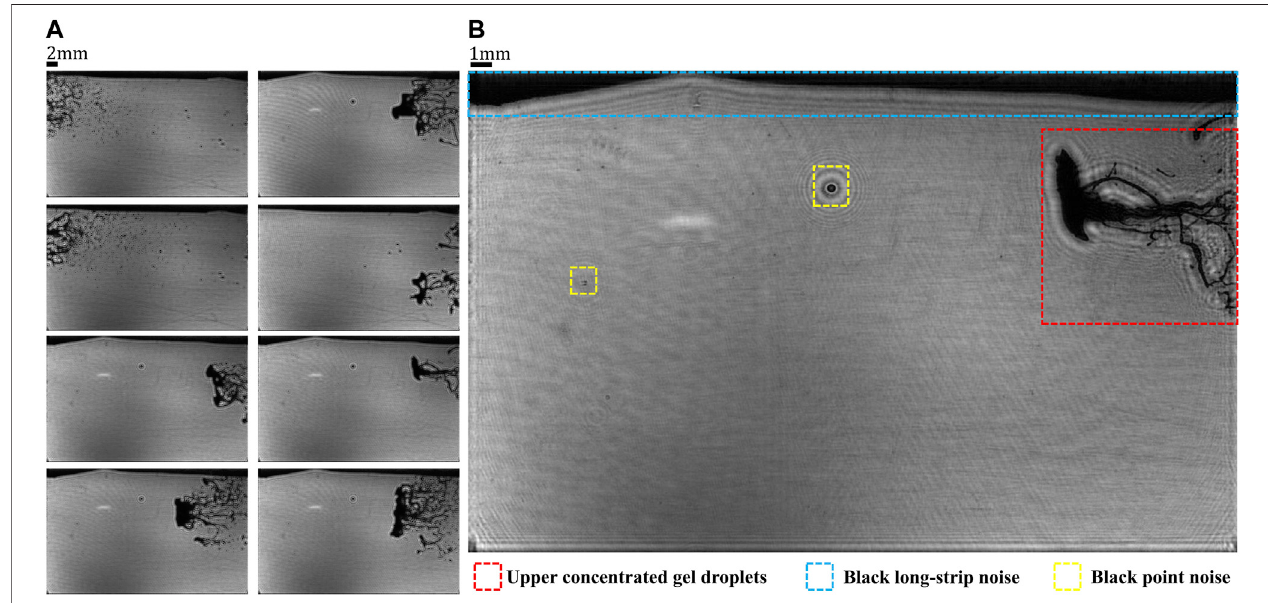
FIGURE 5 | Defective dataset. The subgraphs in column (A) are the images chosen randomly from the dataset with the same defects. The sub fi gure (B) is the speci fi cdefects.Theredframedenoteswheretheunevenspatialdistributionofdropletsare,theblueframedenotestheblacknoiseswithlongblackstripshapeandthe yellow frame refers to the black noise with a dot-like